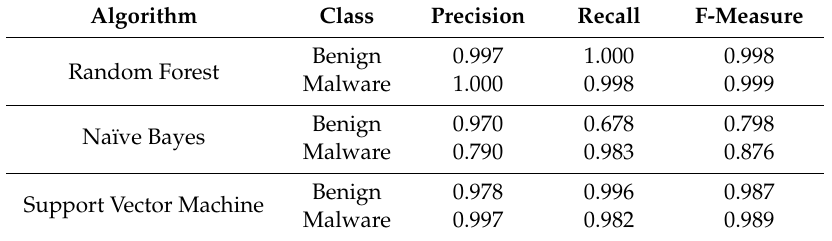
Table 6. The detection performance of machine-learning algorithms with the structure feature model.